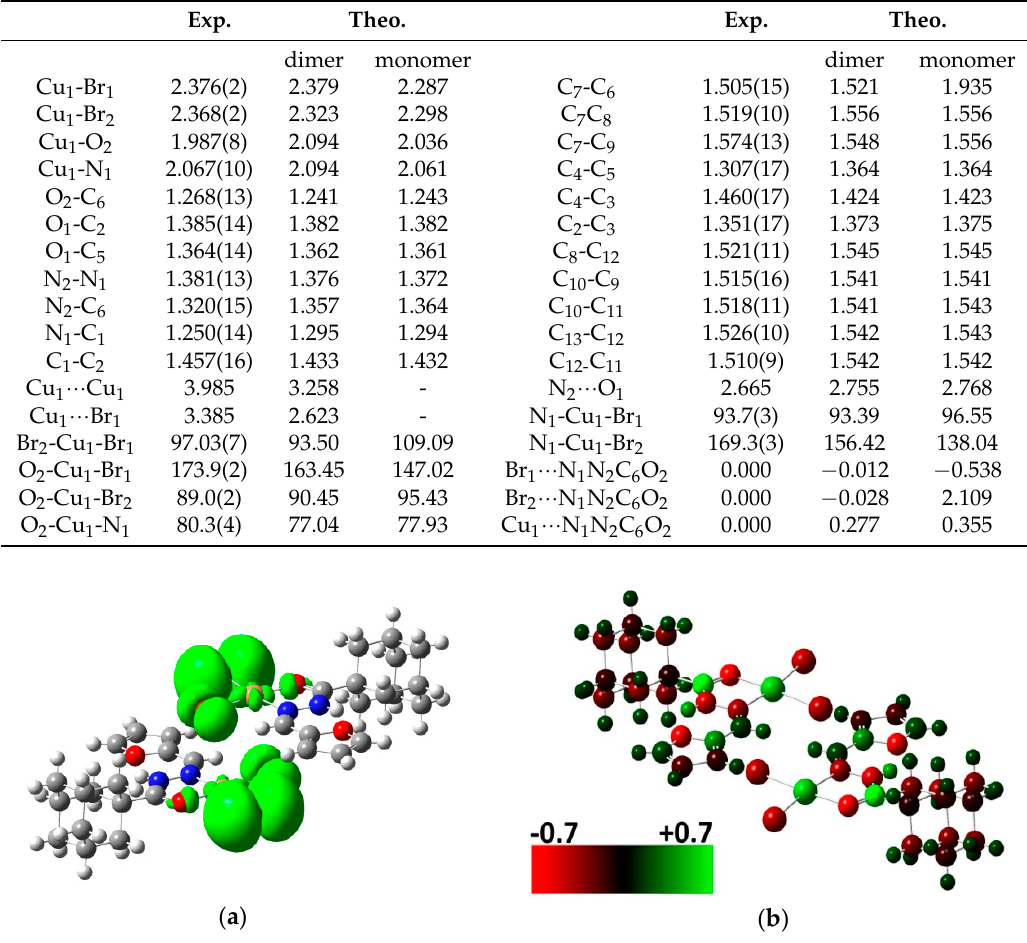
Figure 4. ( a ) ESP (electrostatic potential); and ( b ) Mulliken charge calculations at level 6-31G(d)/B3LYP for the dimer of 1 .